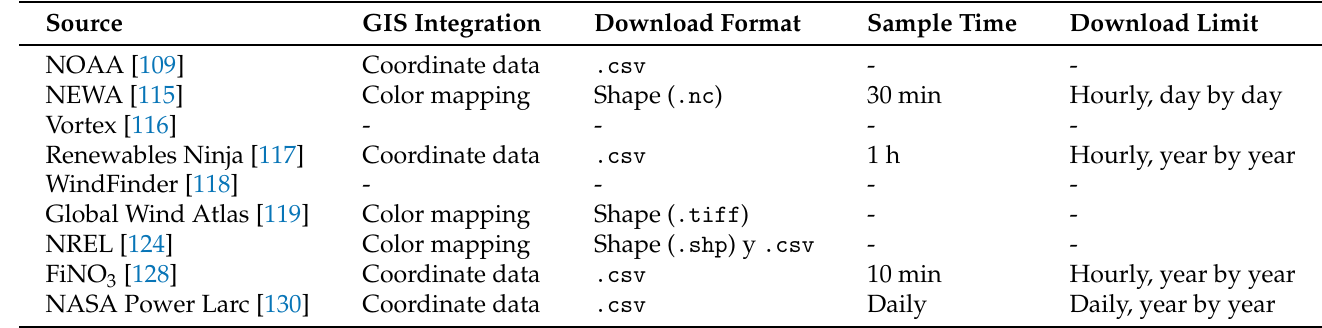
Table 6. GIS tool integration and downloadable format.